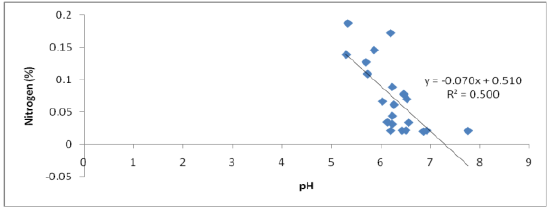
Figure 1 : The relationship between SOM content and the soil pH Relationship between soil pH and soil nitrogen content: - The correlation between soil pH and N was significant (r =-0.707**) but negatively. The coefficient of determination (R 2 ) value was 0.500 that the in-soil pH level 50% to the change in soil nitrogen level while the rest effects was due to other factors as shown in Figure 2. Soil pH had significant effect on change in soil nitrogen level.